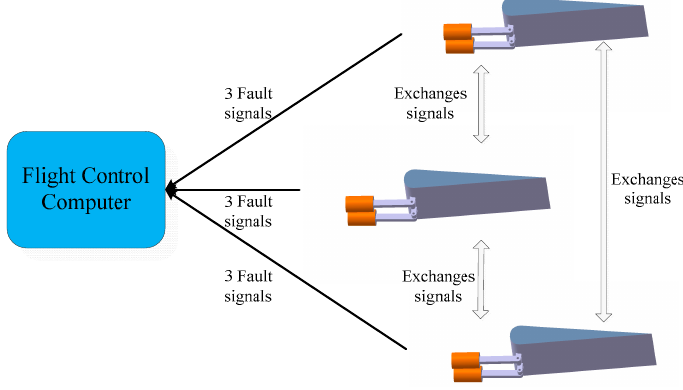
Figure 1. Primary flight control surfaces layout.